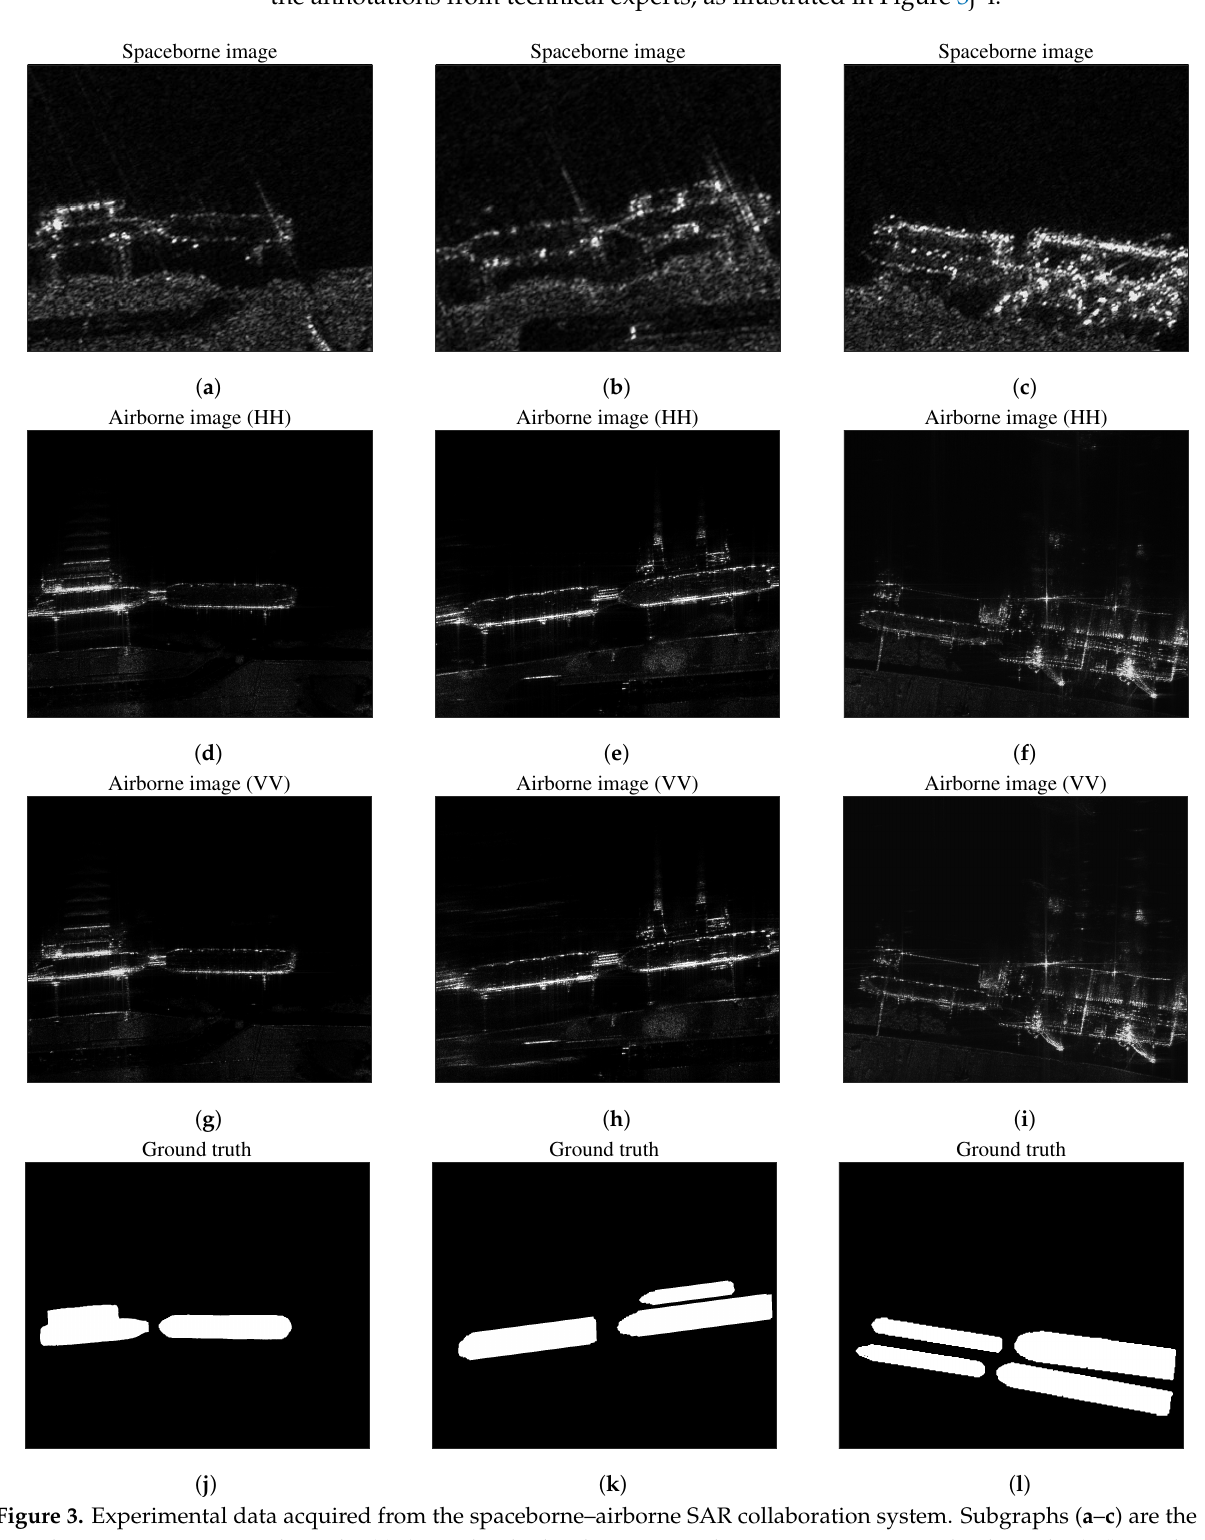
Figure 3. Experimental data acquired from the spaceborne–airborne SAR collaboration system. Subgraphs ( a – c ) are the spaceborne SAR images, subgraphs ( d – i ) are the dual-polarization airborne SAR images, and subgraphs ( j – l ) are the corresponding ground truths. Three scenes are considered in our experiments, which correspond to the three rows; that is, ( a , d , g , j ), ( b , e , h , k ), and ( c , f , i , l ),